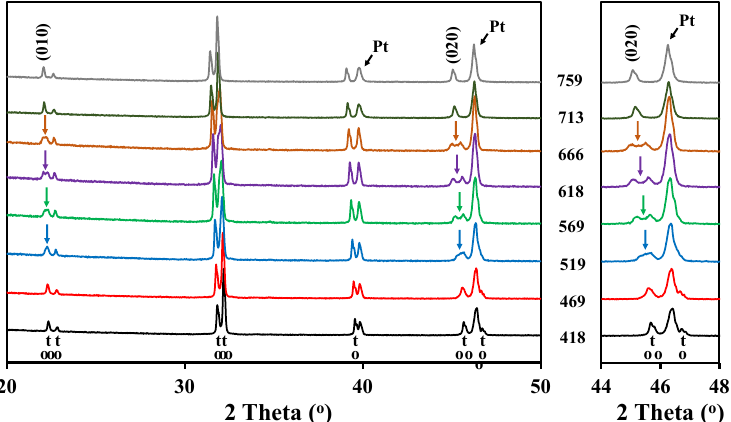
Figure 3. High temperature X ‐ ray diffraction patterns for the layered double perovskite LaBaCo 2 O 5+ δ in N 2 from 418 to 759 °C. The inset shows the range of temperatures where the splitting of (020) is observed. At the bottom of the figure, the Bragg reflections for both tetragonal and orthorhombic structures of LaBaCo 2 O 5+ δ are shown.